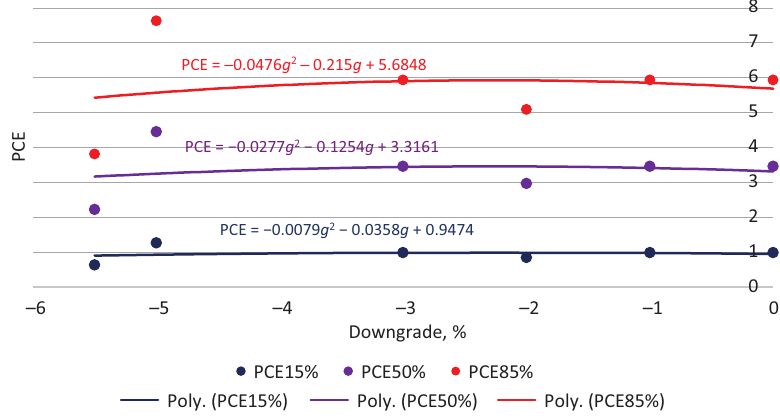
Figure 5. Comparative analysis of PCE commercial vehicles on a